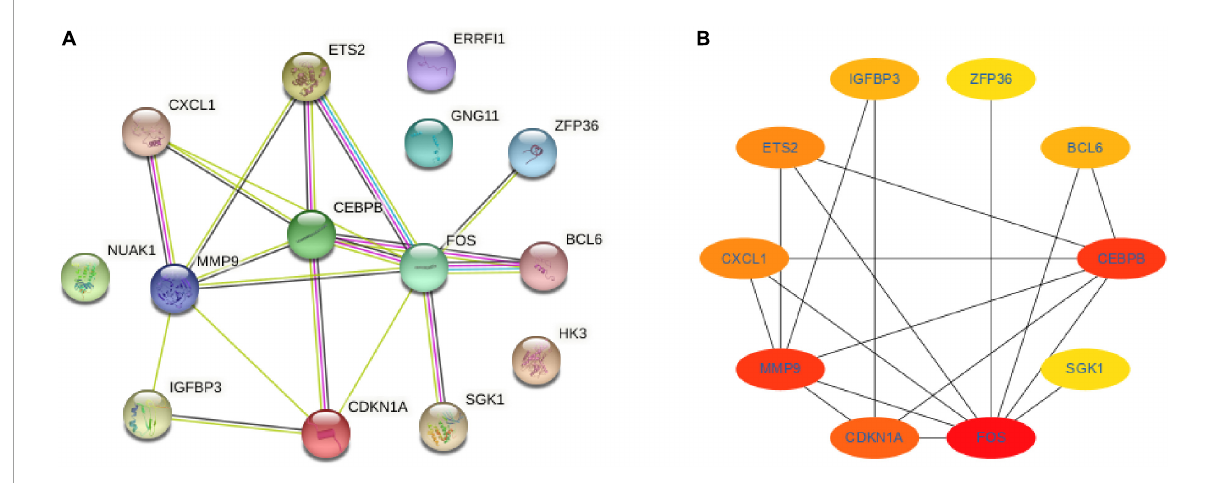
FIGURE7 Protein-protein interaction network and hub genes. (A) Protein-protein interaction network constituted with the DESRGs; (B) top 10 hub genes. Darker colors indicate a higher value. DESRGs, differentially expressed senescence-related